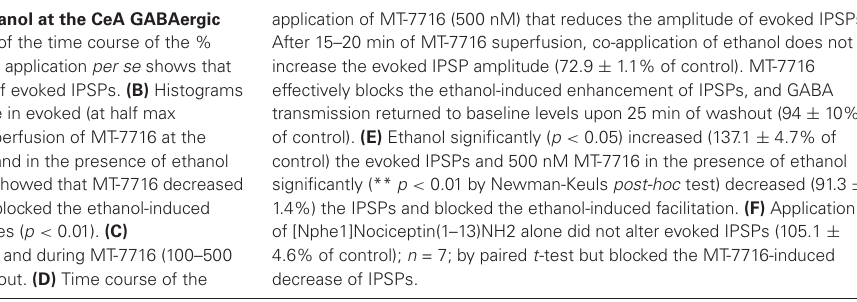
FIGURE 6 | Interactions of MT-7716 and ethanol at the CeA GABAergic synapses. (A) Overall ANOVA for the analyze of the time course of the % IPSP amplitude in CeA neurons during ethanol application per se shows that ethanol significantly increases the amplitude of evoked IPSPs. (B) Histograms representing the percent of the peak decrease in evoked (at half max stimulus intensity) IPSP amplitudes during superfusion of MT-7716 at the concentrations (100, 250 and 500 nM) alone, and in the presence of ethanol 44 mM on top. Newman-Keuls post-hoc test showed that MT-7716 decreased significantly the evoked IPSP amplitudes and blocked the ethanol-induced facilitation. (*) Indicates ( p < 0.05) (**) indicates ( p < 0.01). (C) Representative evoked IPSPs recorded before and during MT-7716 (100–500 nM) and co application with ethanol and washout. (D) Time course of the